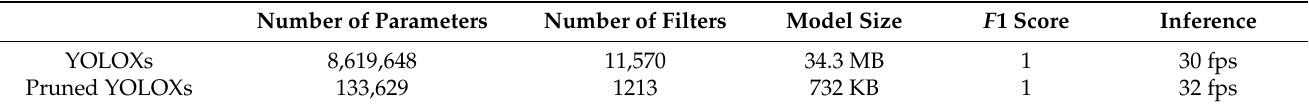
Table 2. Comparison of the parameters before and after pruning.